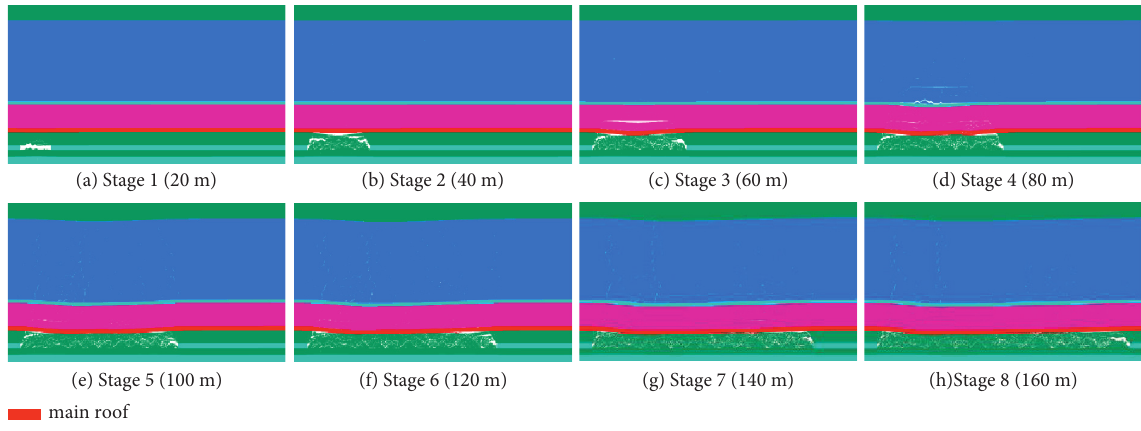
Figure 5: Progressive caving of the overlying strata during the longwall advance. (a) Stage 1 (20m). (b) Stage 2 (40m). (c) Stage 5 (60m). (d) Stage 4 (80m). (e) Stage 5 (100m). (f) Stage 6 (120m). (g) Stage 7 (140m). (h) Stage 8 (160m).